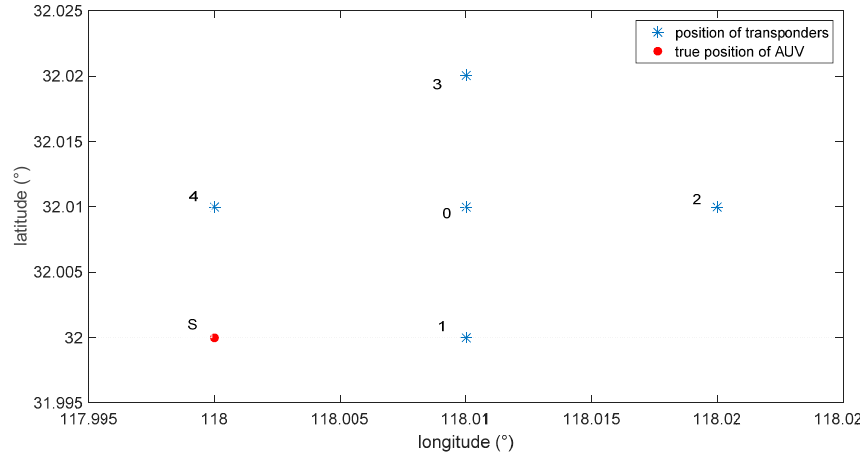
Figure 15. Oscillogram of received signals.